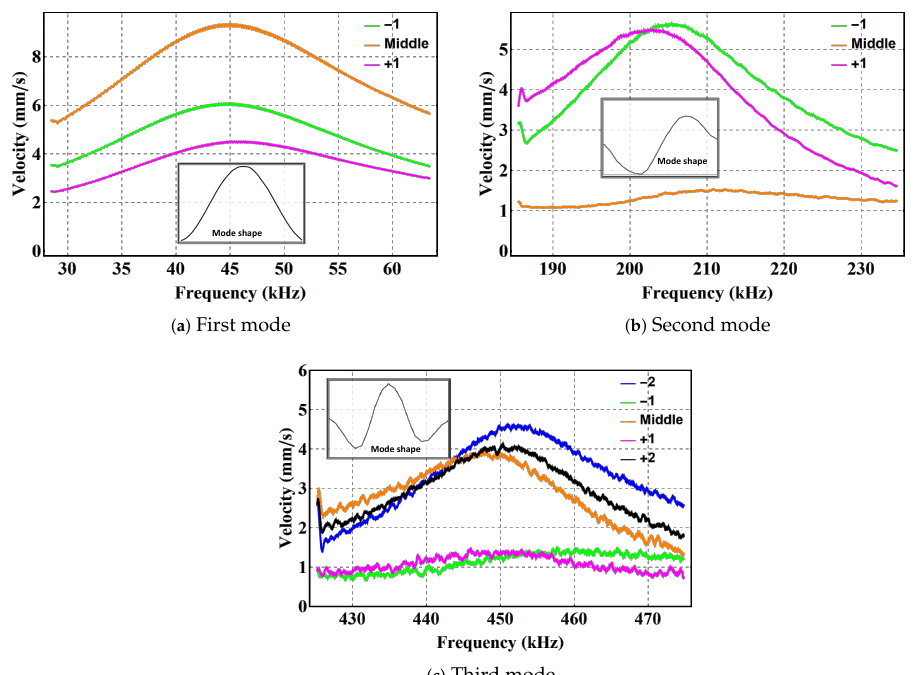
Figure 5. The frequency–response curves at key points along the curved beam in the vicinity of the first, second, and third natural frequencies under half-electrode excitation with the voltage waveform V AC = 2V and V DC =